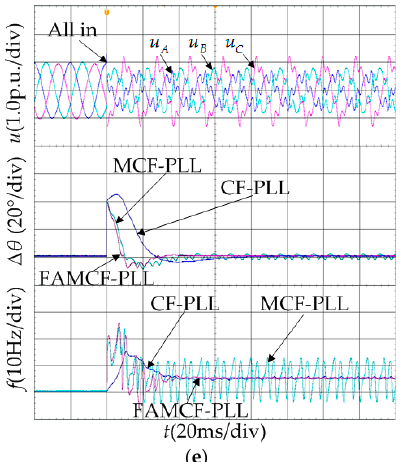
Figure 9. Experimental results of PLLs under distorted grid conditions. ( a ) Condition 1; ( b ) Condition 2; ( c ) Condition 3; ( d ) Condition 4; ( e ) Condition 5. Table 1. Detailed experimental results of the